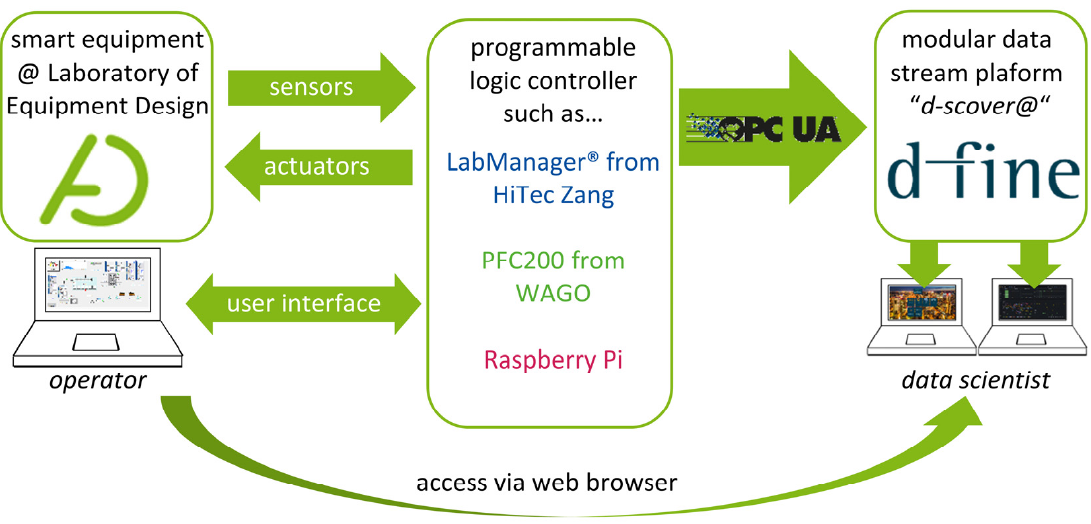
Figure 1. Overview of the connection of the d ‐ scover@ platform to existing smart equipment in laboratories.